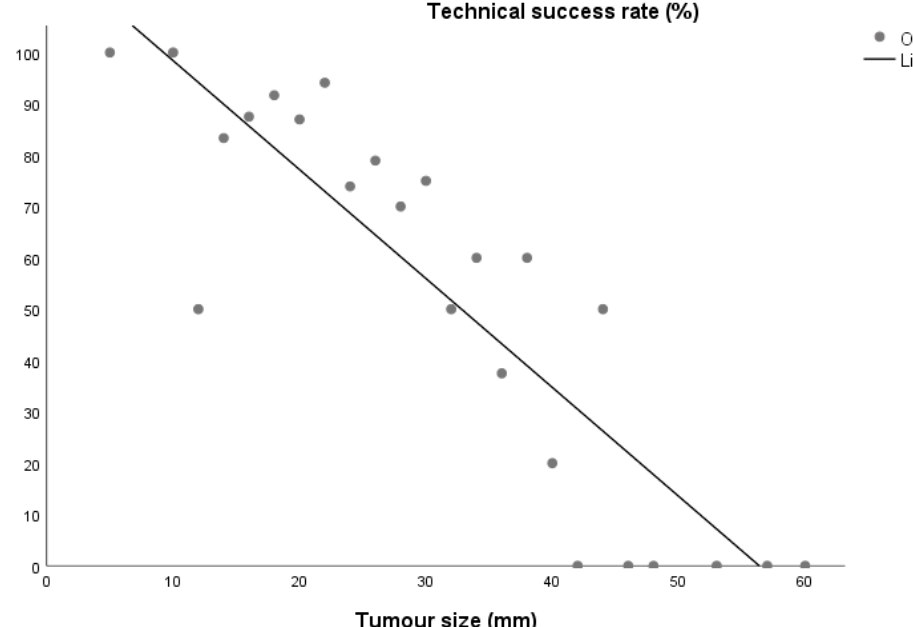
Figure 1. Primary ablation success rate according to tumour size. Table 1. Characteristics of the ablated